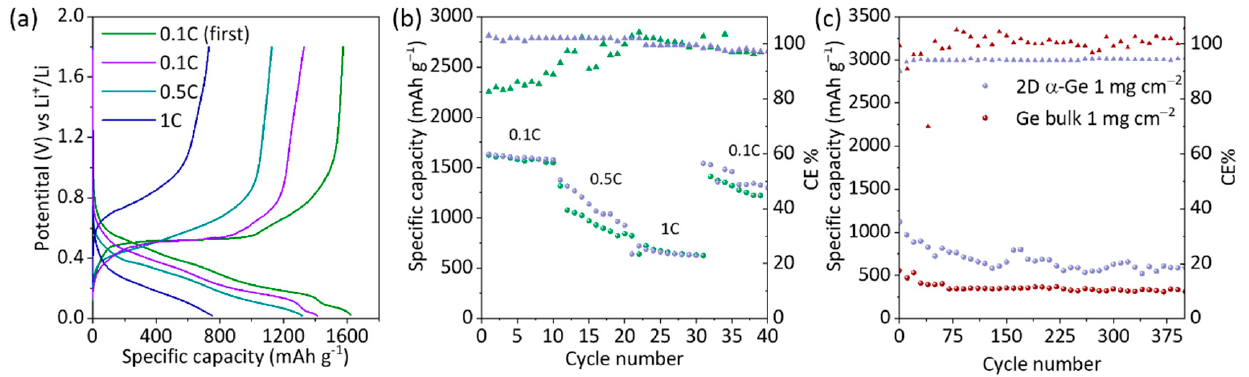
Figure 3. ( a ) GCD profiles of 2D α -Ge 1 mg cm − 2 semi-cell at different scan rates. ( b ) GCD at different scan rates for 2D α -Ge Ge 1 mg cm − 2 semi-cell (purple dots) and 2D α -Ge 2 mg cm − 2 semi-cell (green dots). The triangles indicate the corresponding CE%. ( c ) GCD at constant current rate of 0.5 C over 400 cycles for 2D α -Ge 1 mg cm − 2 semi-cell (purple dots) and Ge bulk 1 mg cm − 2 semi-cell (dark red dots). The triangles indicate the corresponding CE%.